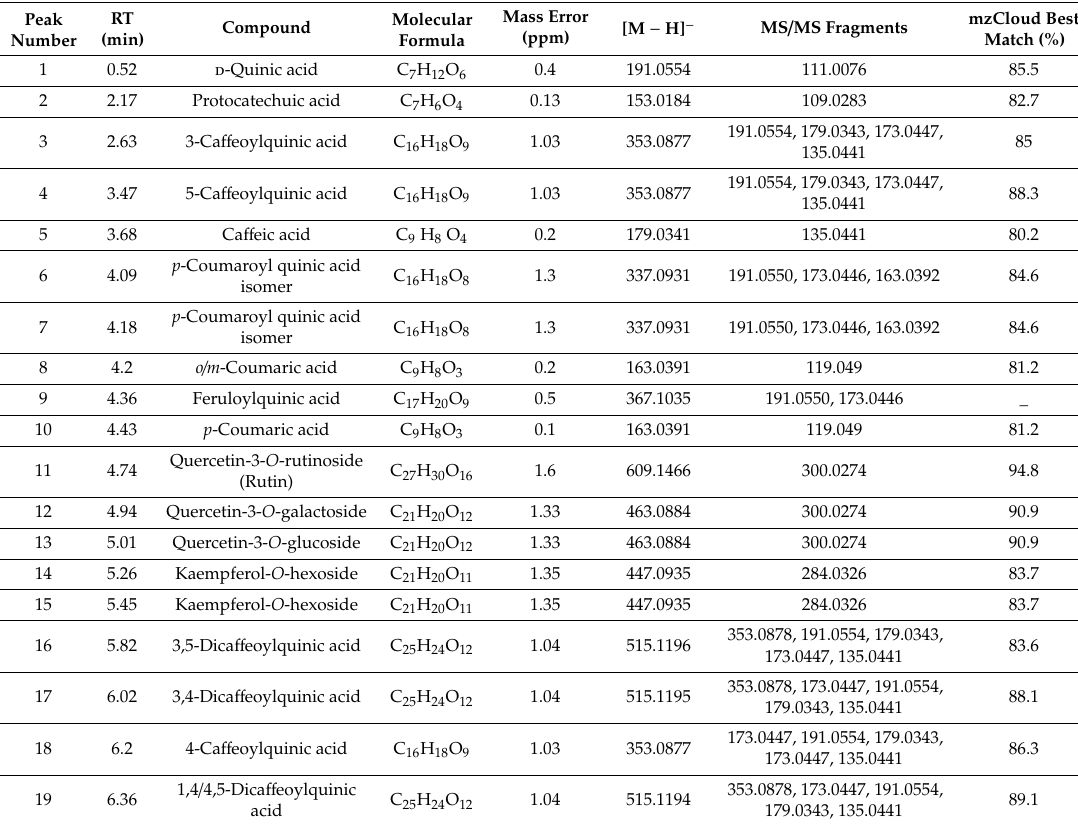
Table 2. Identification of 19 compounds in the Antirhea borbonica acetonic extract by LC-UV-HESI-MS / MS in negative